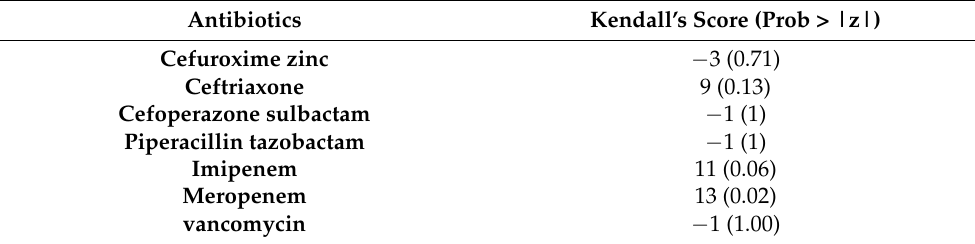
Table 2. Trends of drug use intensity for each grade antibiotics from 2013–2018 in FAH,